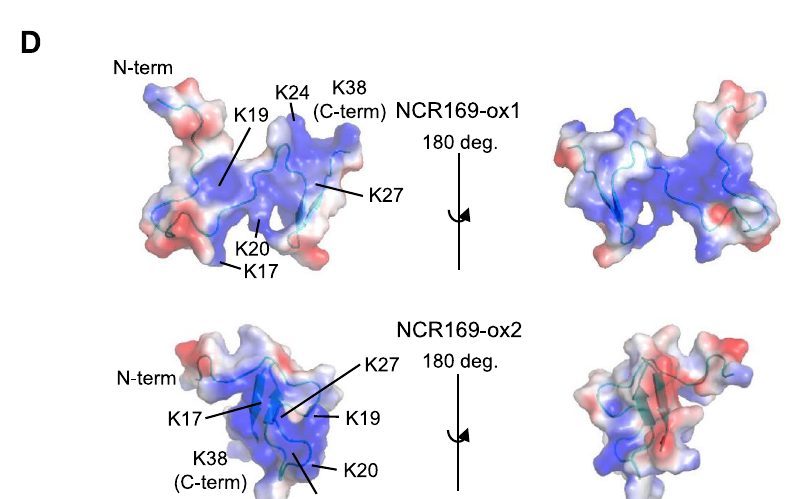
Figure 2. Solution NMR structures of NCR169 oxidized forms. ( A ) 1 H– 15 N heteronuclear single quantum coherence (HSQC) spectra of NCR169-ox1 (left), NCR169-ox2 (middle), and NCR169-red (right). In the NCR169-ox1 and NCR169-ox2 spectra, signals are labeled with amino acid type and residue number. In the NCR169-red spectrum, only the signals predicted from other spectra are labeled. ( B ) Ribbon models of NCR169-ox1 (left) and NCR169-ox2 (right). Two pairs of disulfide linkages are depicted in the ball-and-stick model. The secondary structural regions were estimated using the MOLMOL program. ( C ) Structural overlay of NCR169-ox1 (blue) and -ox2 (red). Only their backbones are depicted. ( D ) The electrostatic distribution was plotted on the molecular surface of NCR169-ox1 (upper) and NCR169-ox2 (lower). The negative, positive, and hydrophobic surfaces are shown in red, blue, and white, respectively. The lysine residues forming a positively charged cluster are